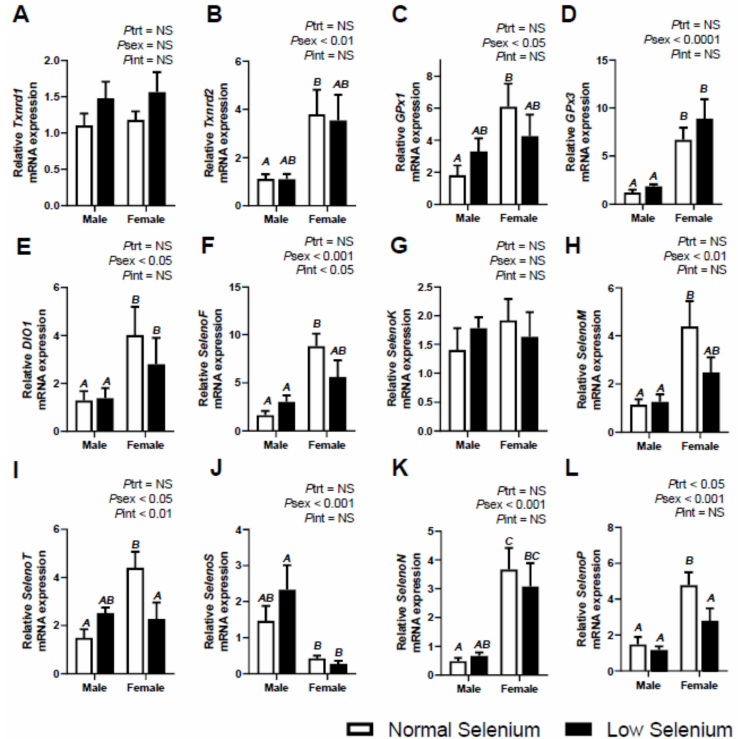
Figure 4. E ff ects of selenium deficiency on selenoprotein expression in o ff spring liver at PN180. Expression in male and female o ff spring livers, at PN180, of; ( A ) thioredoxin reductase 1, ( B ) thioredoxin reductase 2, ( C ) glutathione peroxidase 1, ( D ) glutathione peroxidase 3, ( E ) deiodinase 1, ( F ) selenoprotein F, ( G ) selenoprotein K, ( H ) selenoprotein M, ( I ) selenoprotein T, ( J ) selenoprotein S, ( K ) selenoprotein N and ( L ) selenoprotein P. Data are mean ± SEM and analysed by two-way ANOVA with treatment ( P trt ) and sex ( P sex ) as major factors. P int represents the interaction between treatment and sex. Significance was determined as p < 0.05. If a major e ff ect of treatment, sex or an interaction between treatment and sex was identified, then a Sidak posthoc test was performed. Significant di ff erences between groups as detected by posthoc analysis are denoted by di ff erent letters where “A” is di ff erent from “B” which is di ff erent from “C”. “A” is not di ff erent from “A” or “AB”, while “B” is not di ff erent from “B”, “AB” or “BC”. The groups are Normal male, n = 8 (8 animals from 8 separate litters); Low male, n = 8 (from 8 separate litters); Normal female, n = 8 (from 8 separate litters); Low female, n = 6 (from 6 separate